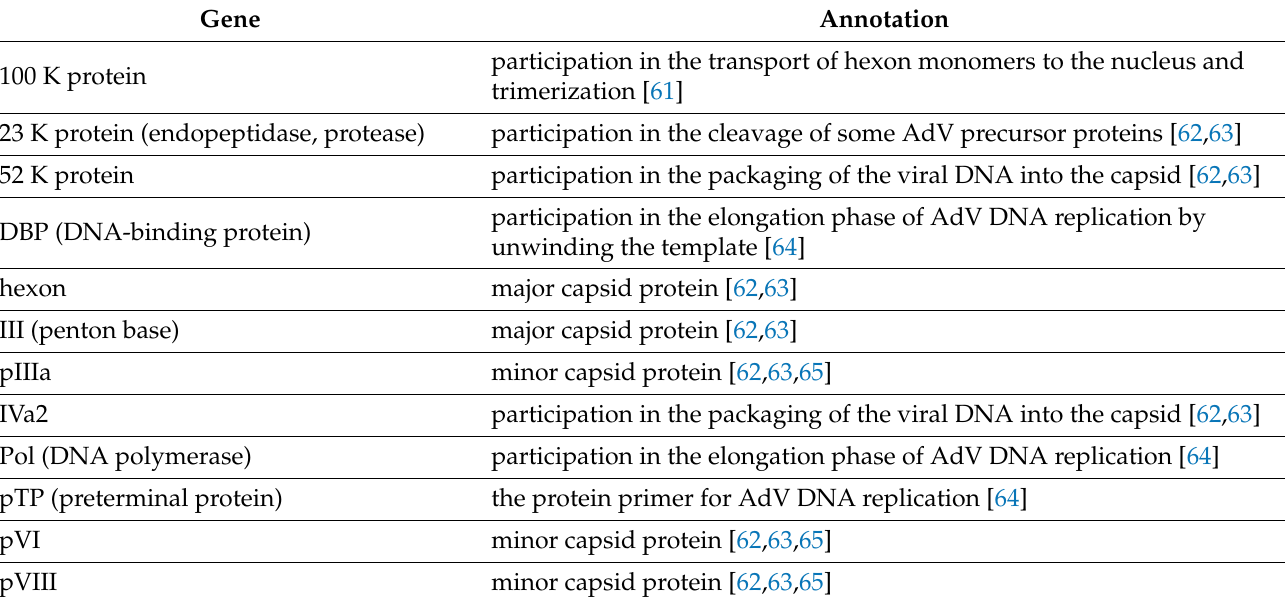
Table 2. The list of the core genes of the adenoviruses is determined based on the analysis of groups of orthologous genes of the studied set of genomes of the type representatives of the family.